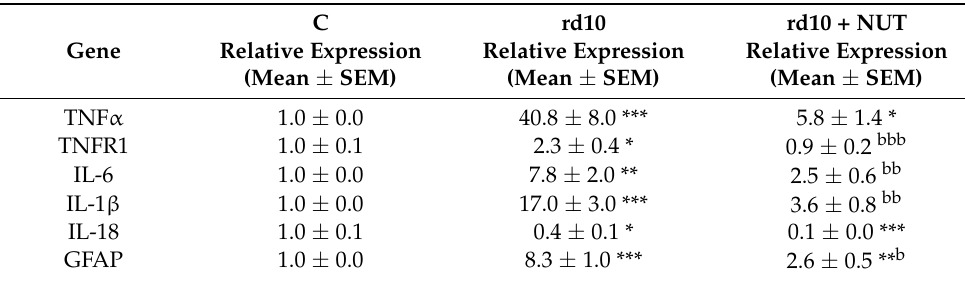
Table 2. Gene expression of inflammatory molecules in retinas from rd10 mice with or without oral administration of